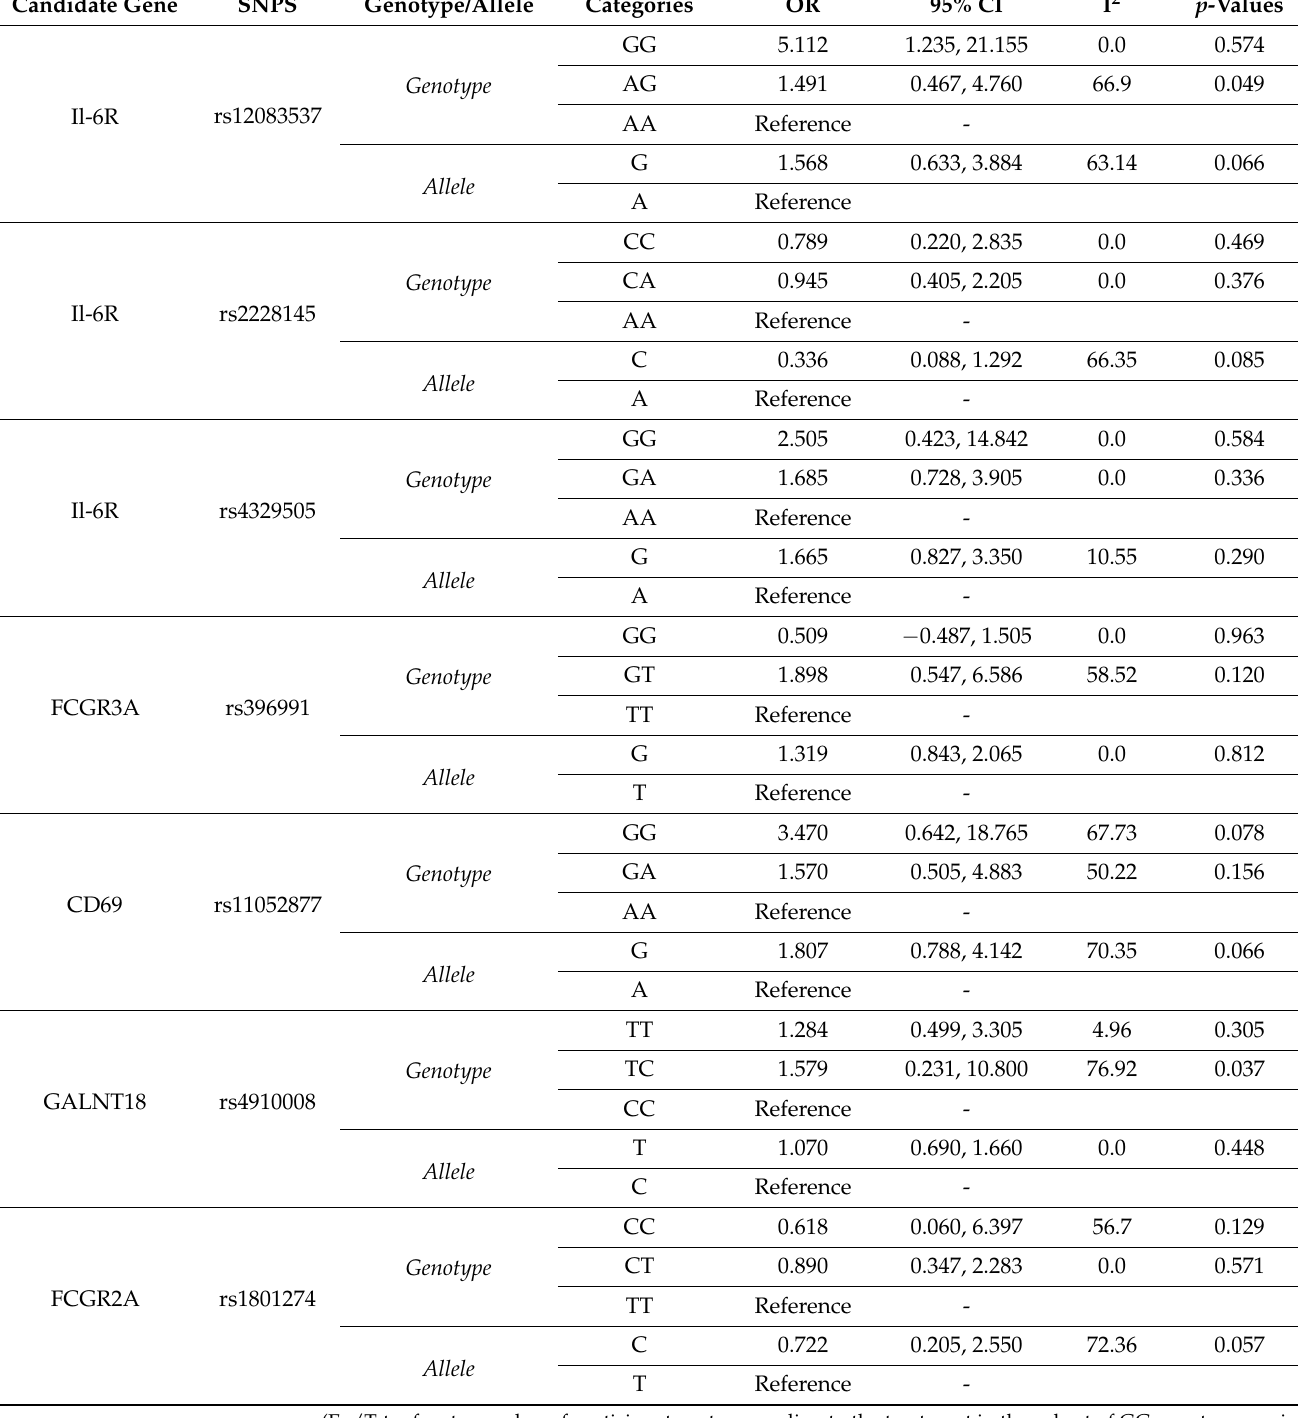
Table 2. Summary of meta-analysis